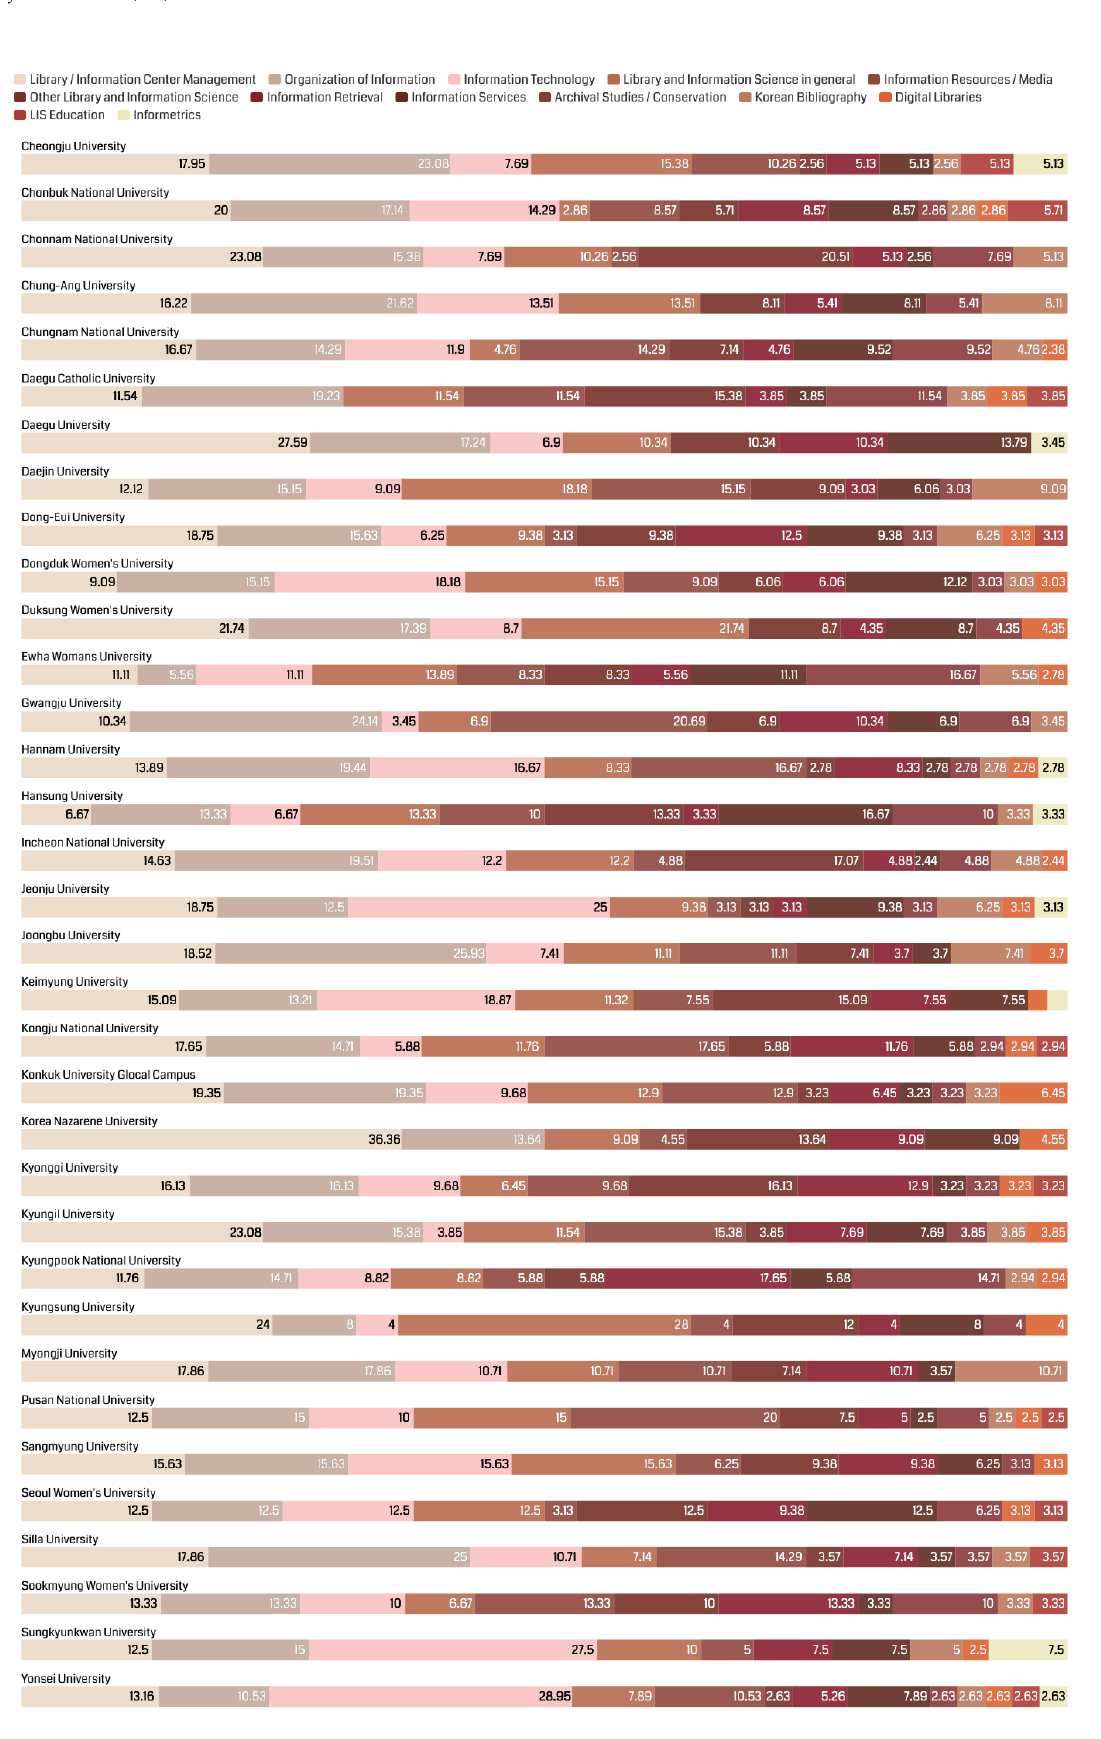
Figure 4. The percentage of courses based on the academic classification at